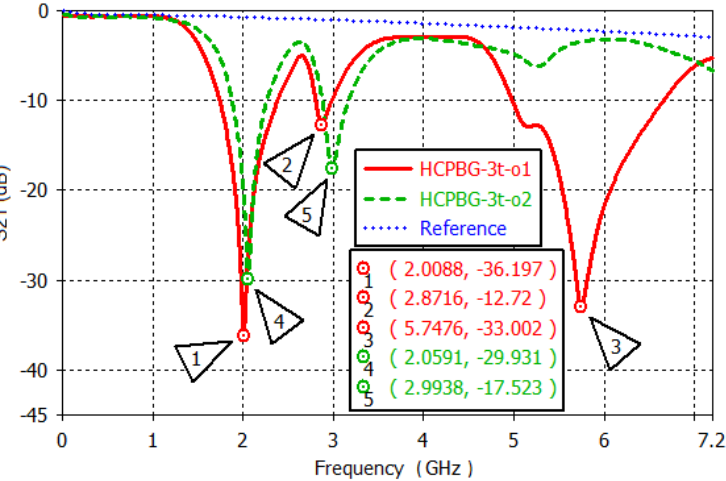
Figure 5. Simulation—transmission loss for HCPBG with 3 traces—orientations o1 and o2. Figure 6 shows the transmission loss simulation results for the 6-trace HCPBG, Table 1 case (f), with outer gaps of 1.5 and 0.5 mm. A smaller gap results in a greater capacitance, leading to lower rejection band frequencies. The HCPBG-6t with a gap of 1.5 mm has a significant bandwidth response if we use a criterion of − 5.8 dB (BW = 3.16 GHz). This structure could be helpful in the suppression of broadband